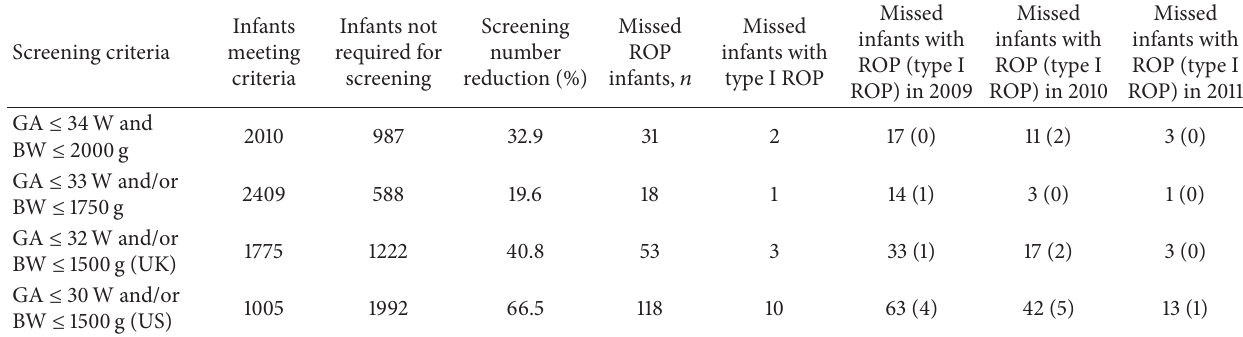
Table 4: Evaluation of different screening criteria for ROP.